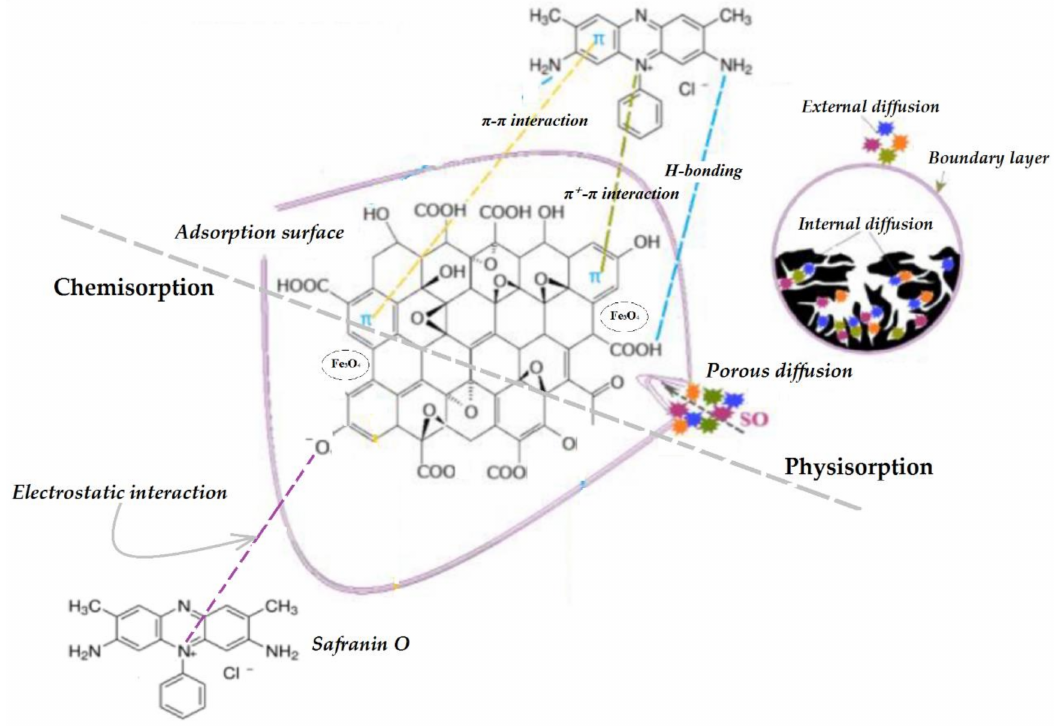
Figure 8. Depicting the possible adsorption mechanism of SO on both RSB and